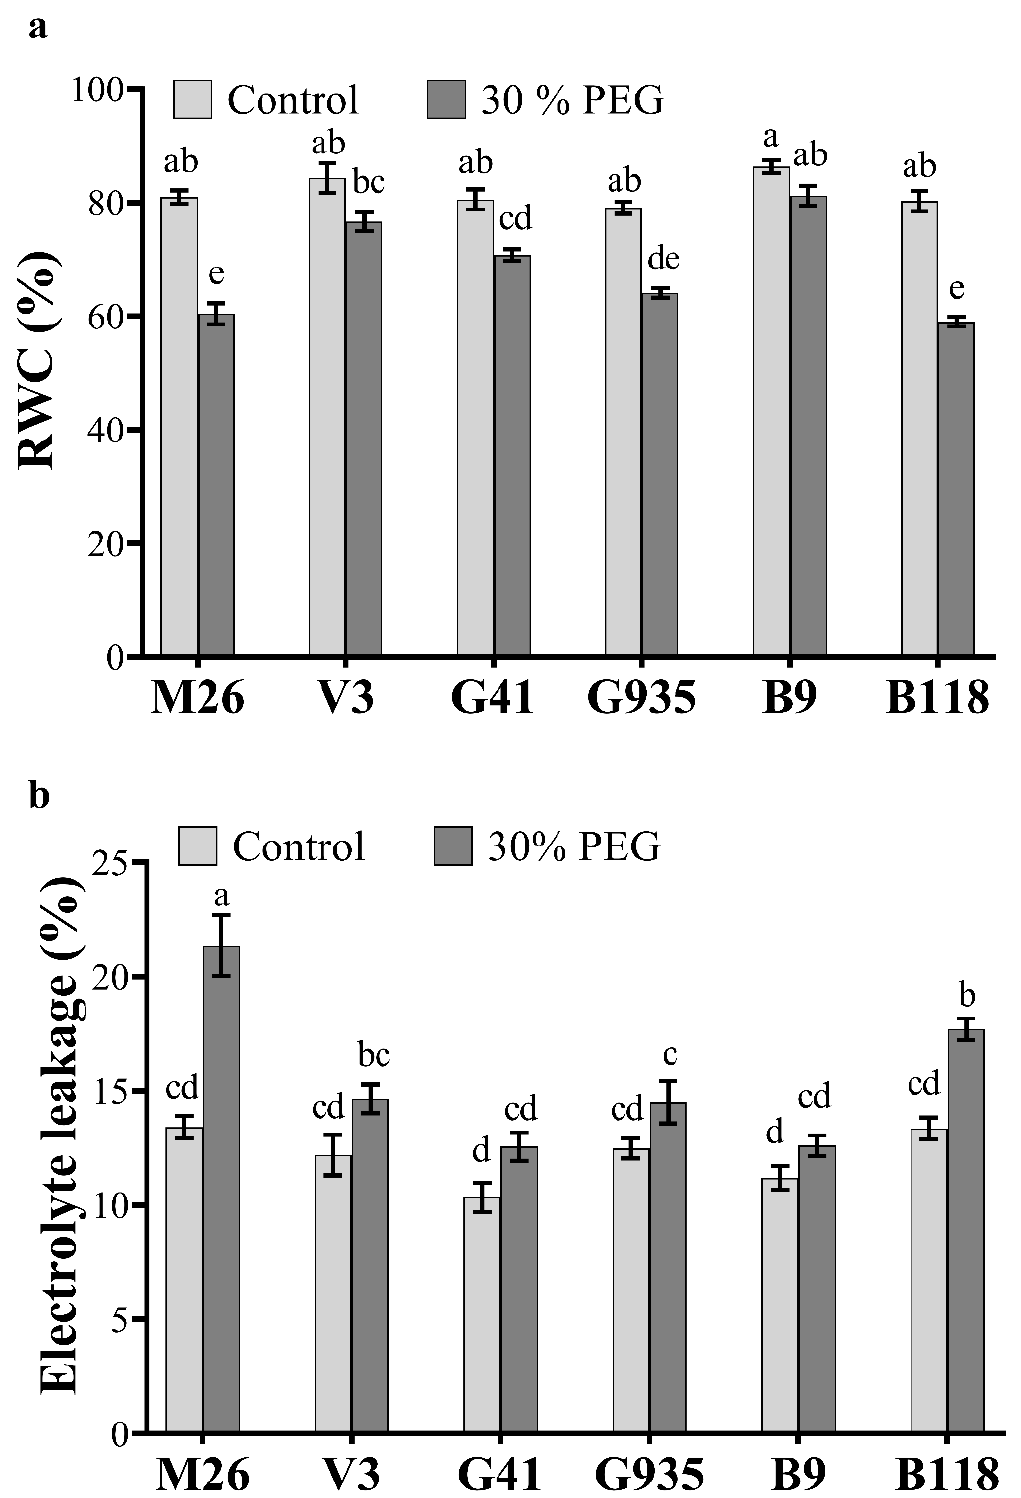
Figure 1. Physiological changes in six apple rootstocks in response to osmotic stress. Relative water content (RWC) ( a ) and electrolyte leakage (EL) ( b ) in six apple rootstocks (M26, V3, G41, G935, B9 and B118) were assessed three days after treatment with 30% PEG. Means from all treatments were compared with each other using Tukey’s test. Vertical bars represent the mean ± SEM of three biological replicates (three plants each). Bars with no common letters are significantly different ( p < 0.05).